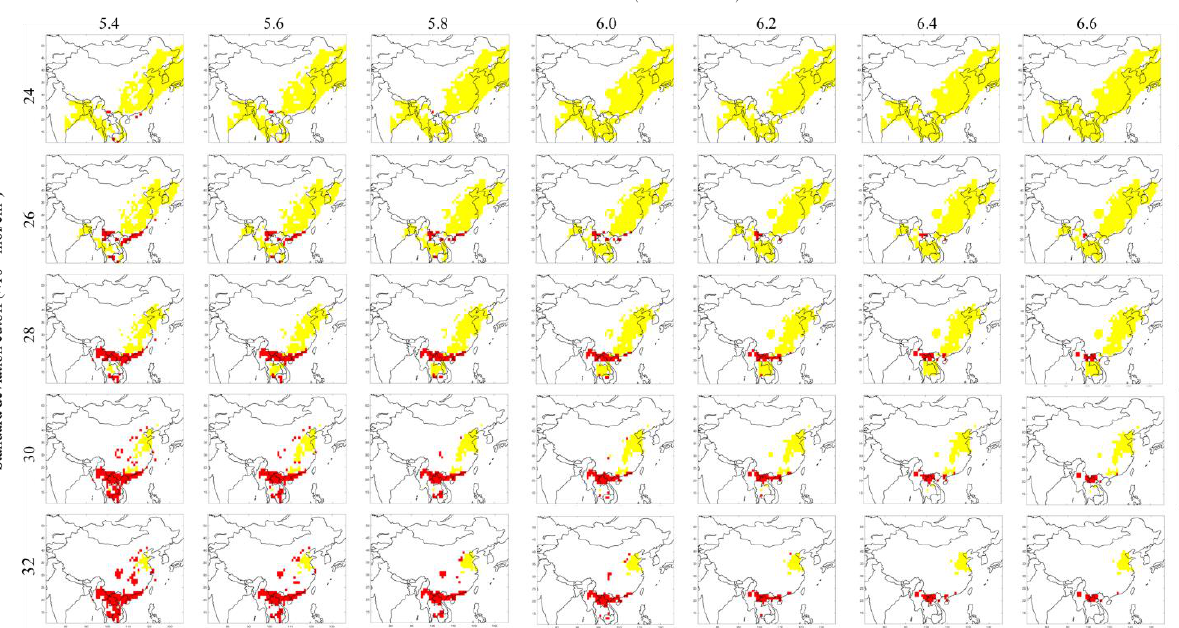
Figure 5. Maps of urban regions (yellow) and biomass burning regions (red), using different cutoff values for CO column mean (changes vertically from top to bottom corresponding respectively to a CO column concentration of 24  10 17 mol/cm 2 through 32  10 17 mol/cm 2 ) and CO column standard deviation (changes horizontally from left to right, corresponding respectively to a CO column standard deviation of 5.4  10 17 mol/cm 2 through 6.6  10 17 mol/cm 2